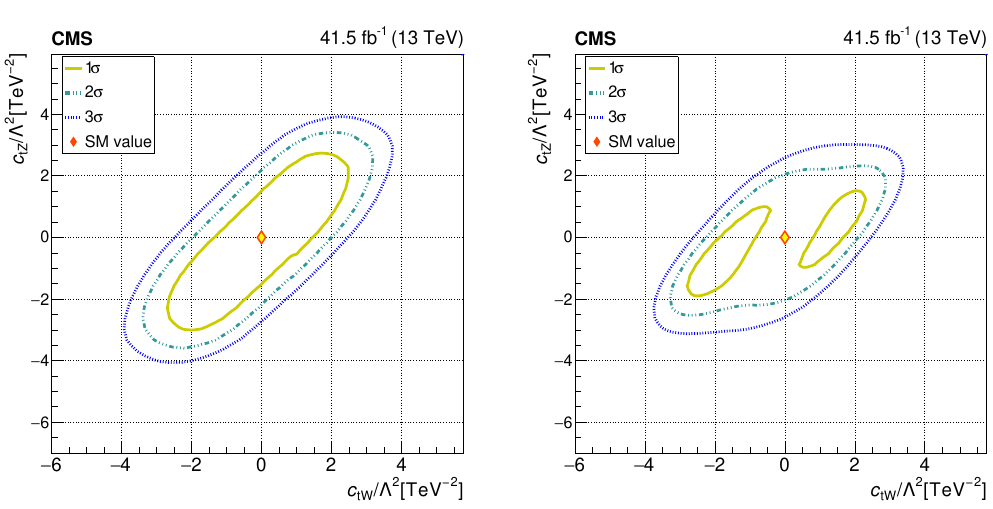
and c with tZ tW